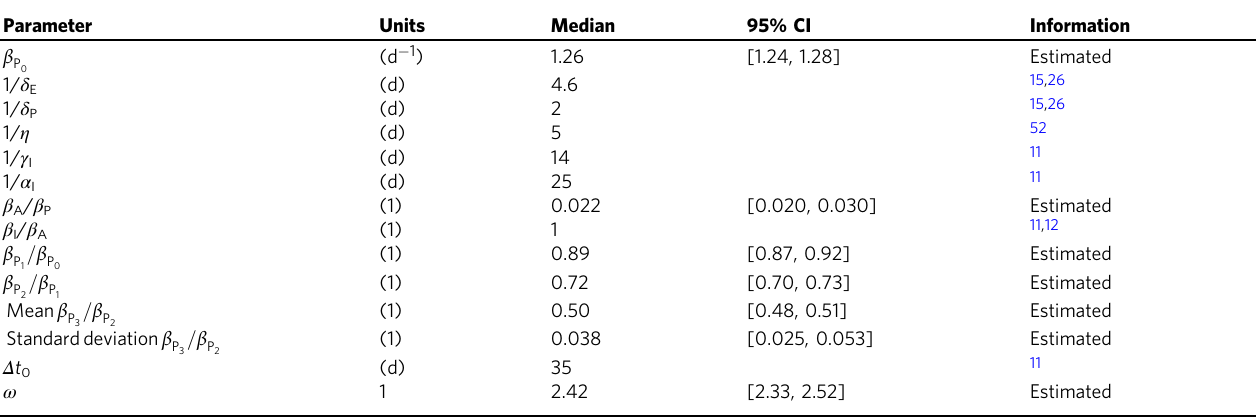
The posterior distribution of the parameters marked as estimated was sampled through the DREAM ZS implementation of the Markov chain Monte Carlo algorithm 53 . For all estimated parameters, we used uninformative priors within biologically meaningful boundaries. Following our previous application 11 , we assumed σ = 0.25, r S = 0.5, ζ = 0.45, and r E = r P = r A = r R = r S , whereas r I = r Q = r H = 0. Moreover, γ Q = γ I = γ H , γ A = 2 γ I , and α H = α I